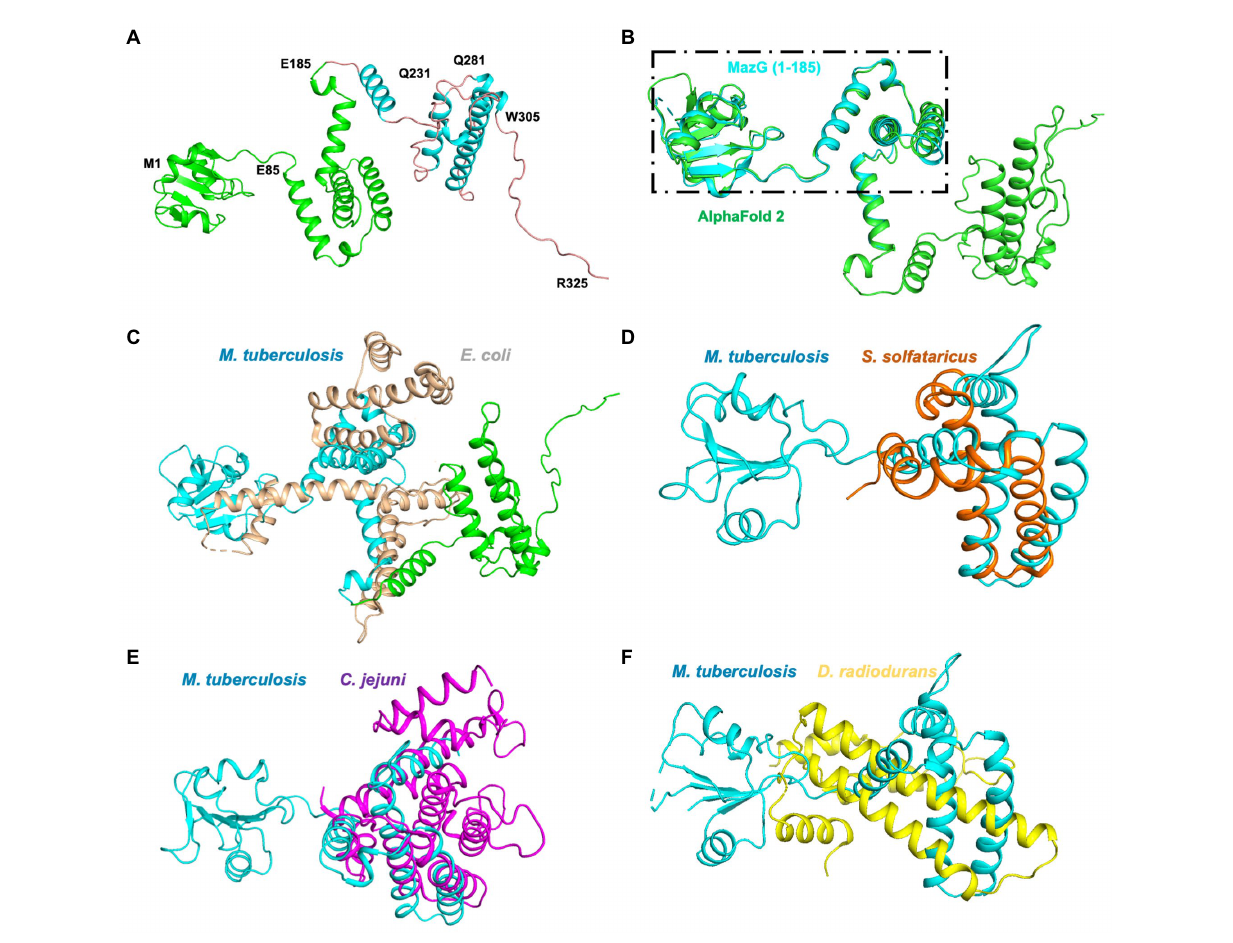
FIGURE 6 Structure superimposition of Mtb-MazG and its homologous proteins. (A) The AlphaFold2-predicted structure of MazG is shown in the cartoon model with different colors. The crystal structure of MazG (1–185) is shown in green color. Different numbers denote the truncated fragments. (B) The structural superposition of Mtb MazG (1–185; cyan) and AlphaFold2-predicted full-length MazG (green). (C) The AlphaFold2-predicted full-length MazG (cyan and green) was superimposed with E. coli MazG (PDB code 3CRC; wheat). (D–F) Structural superimposition of Mtb MazG (1–185; cyan) with S. solfataricus MazG (PDB code 1VMG; orange), C . jejuni MazG (PDB code 1W2Y; purple), and D. radiodurans MazG (PDB code 2YFD;